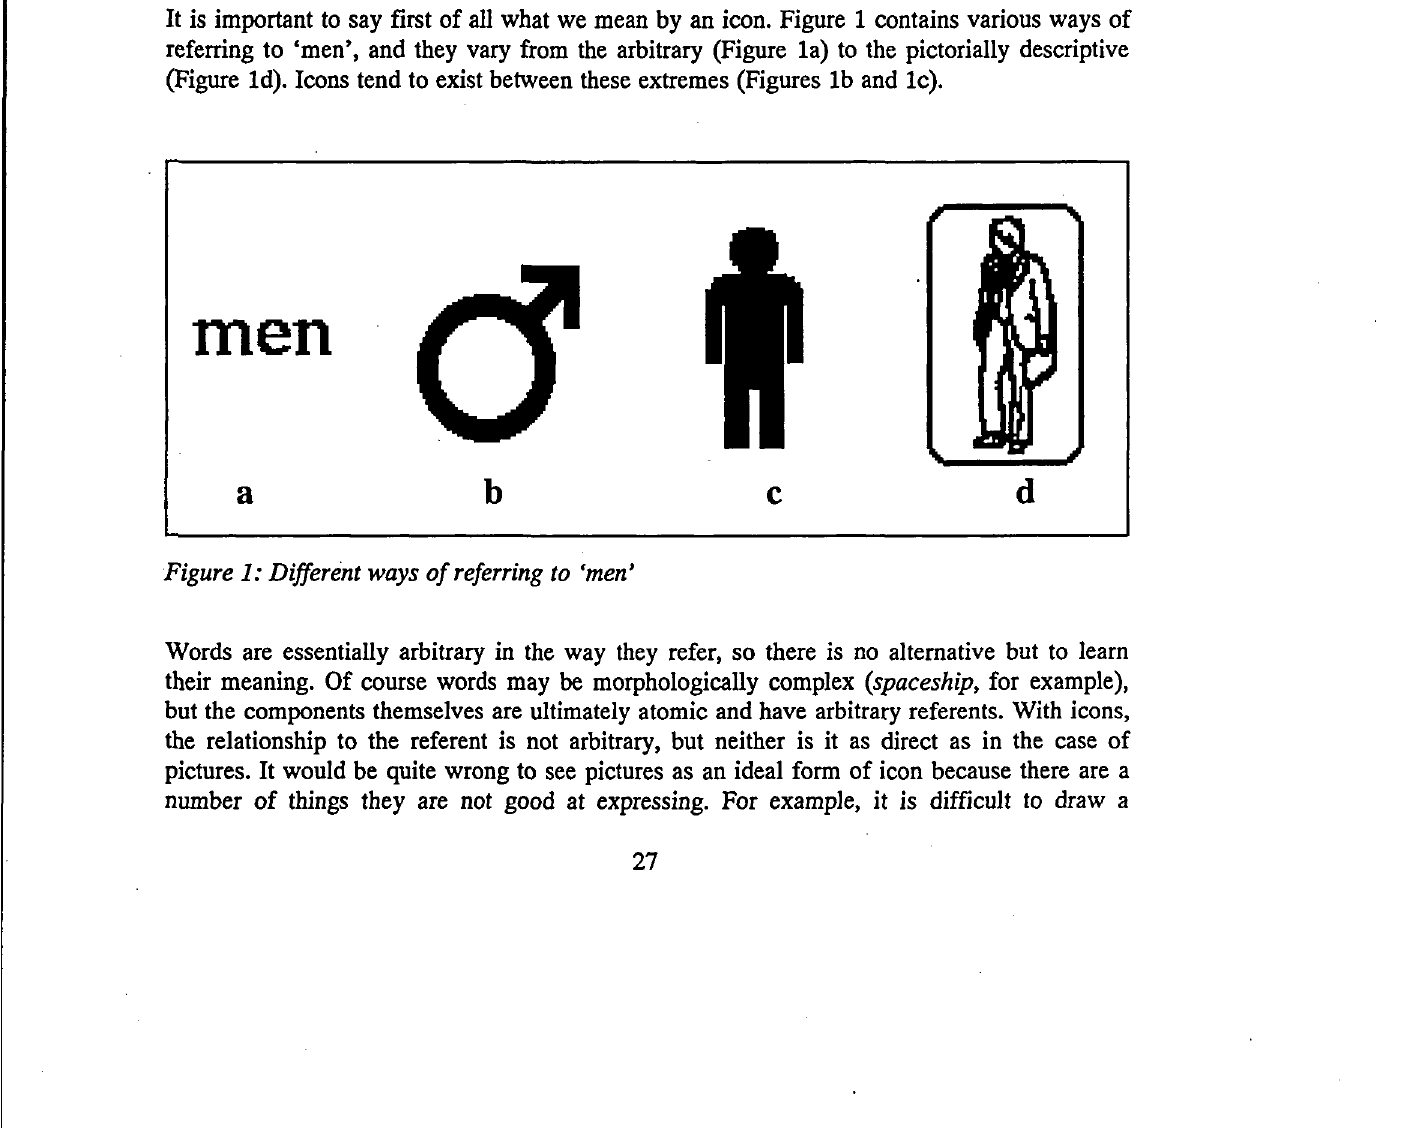
Figure 1: Different ways of referring to